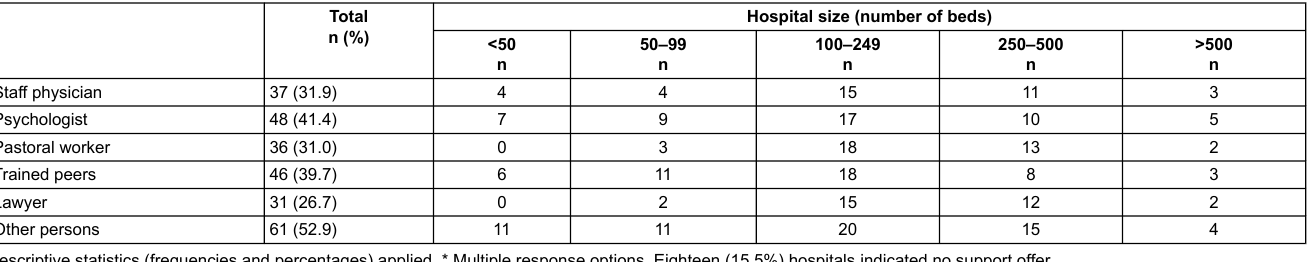
Table 4: Hospitals specific support offers for their health professionals * .